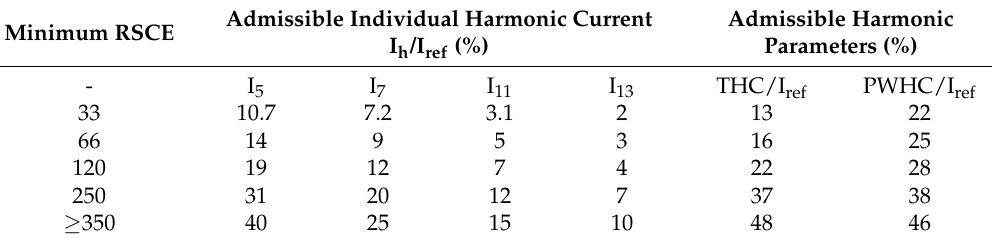
Table 1. Maximum Harmonic Current Distortion set in IEC 61000-3-12